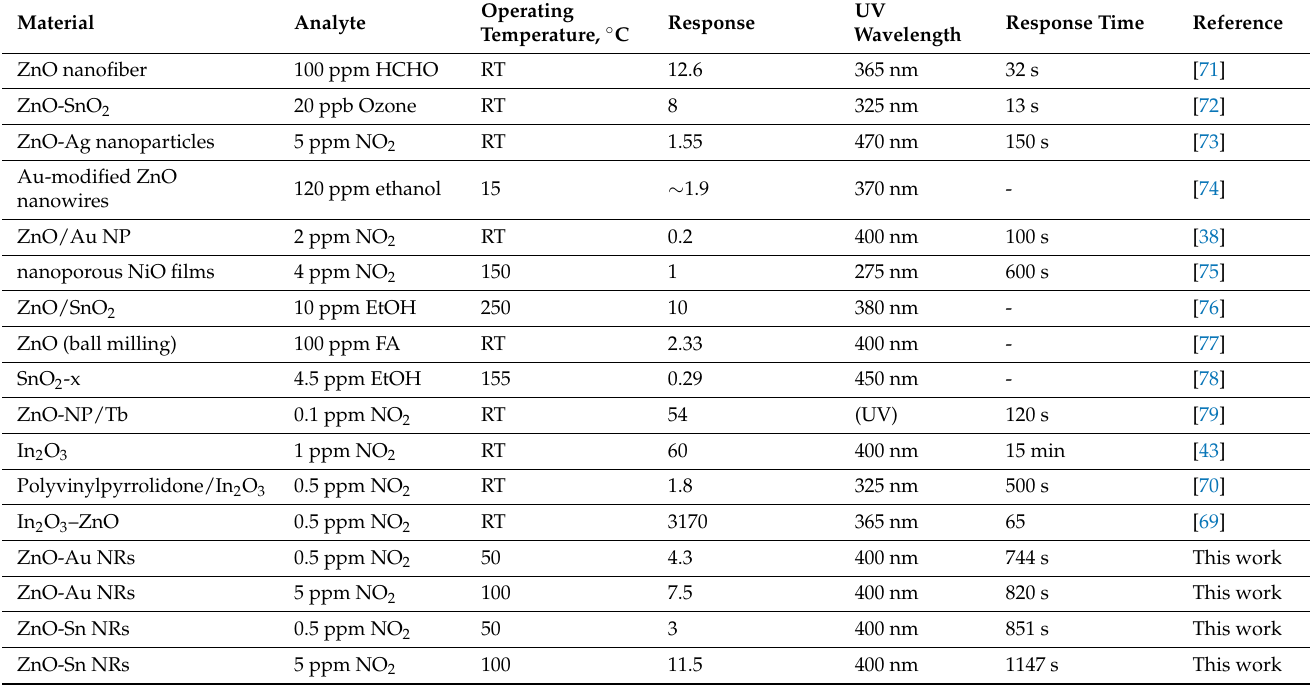
Table 2. Summary of the performance of metal oxide gas sensors to various gases under UV